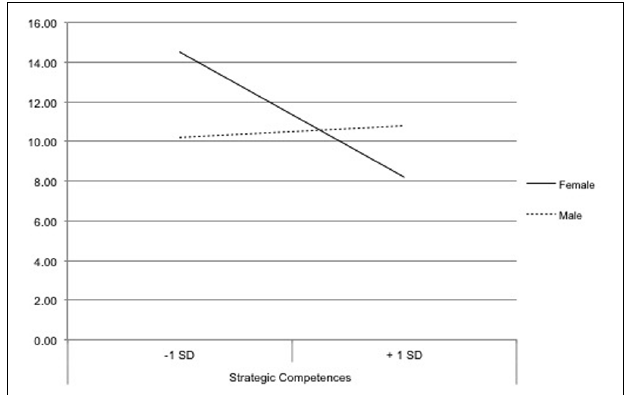
FIGURE 3 | Interaction effect between gender and strategic competences on participants’ mental